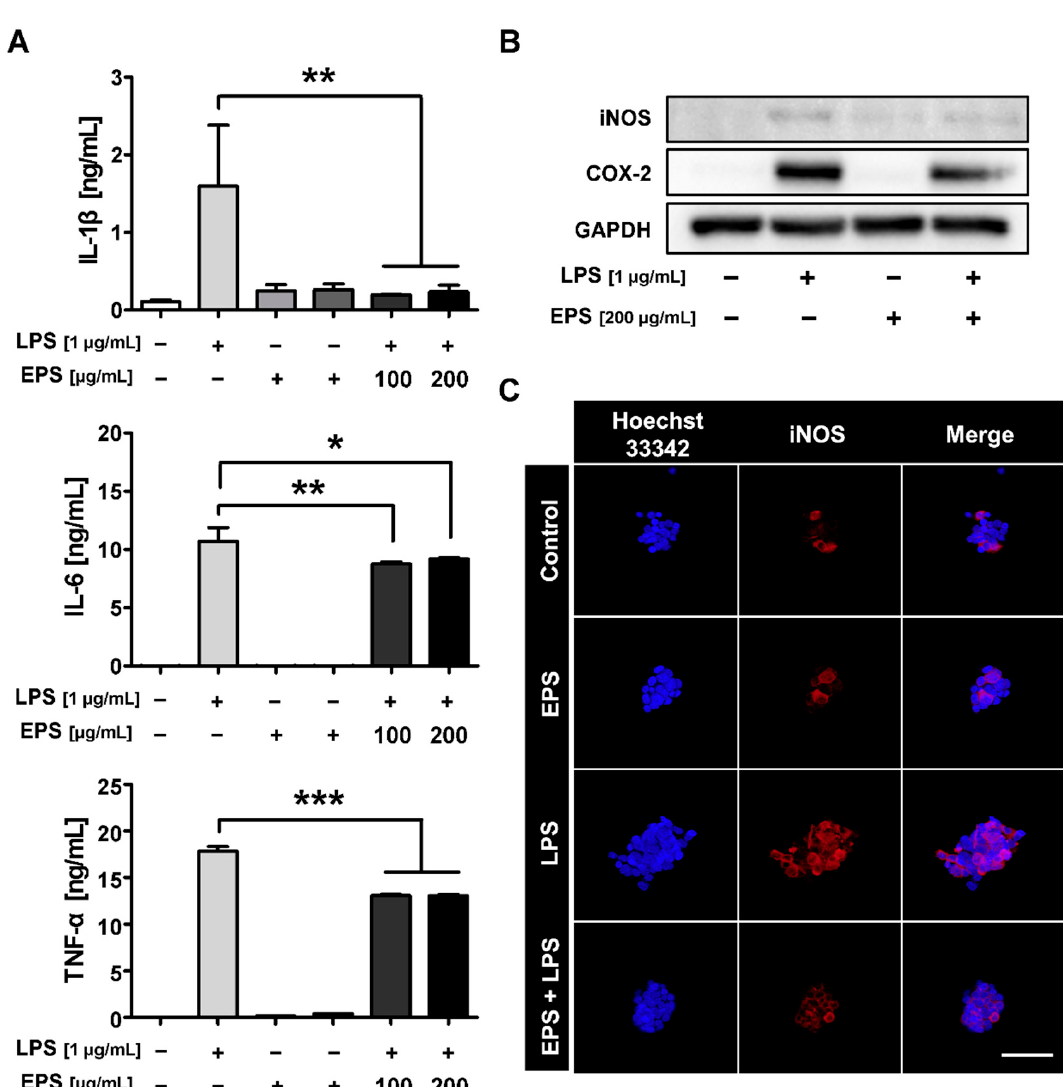
Figure 4. EPS inhibited the LPS-induced inflammatory response in RAW 264.7 cells. ( A ) Cells were pretreated with EPS, and proinflammatory cytokines were quantified using ELISA; EPS attenuated the expression levels of IL-6, TNF- α , and interleukin-1 β (IL-1 β ). ( B ) EPS suppressed the expression of cyclooxygenase-2 (COX-2) and inducible nitric oxide synthase (iNOS) proteins induced by LPS in RAW 264.7 cells. ( C ) The expression of iNOS stimulated by LPS was inhibited in EPS-pretreated RAW 264.7 cells as shown by immunofluorescence (IF) assay. * p < 0.05, ** p < 0.01, and *** p < 0.001 versus the LPS-treated group. Scale bar = 50 μ m.